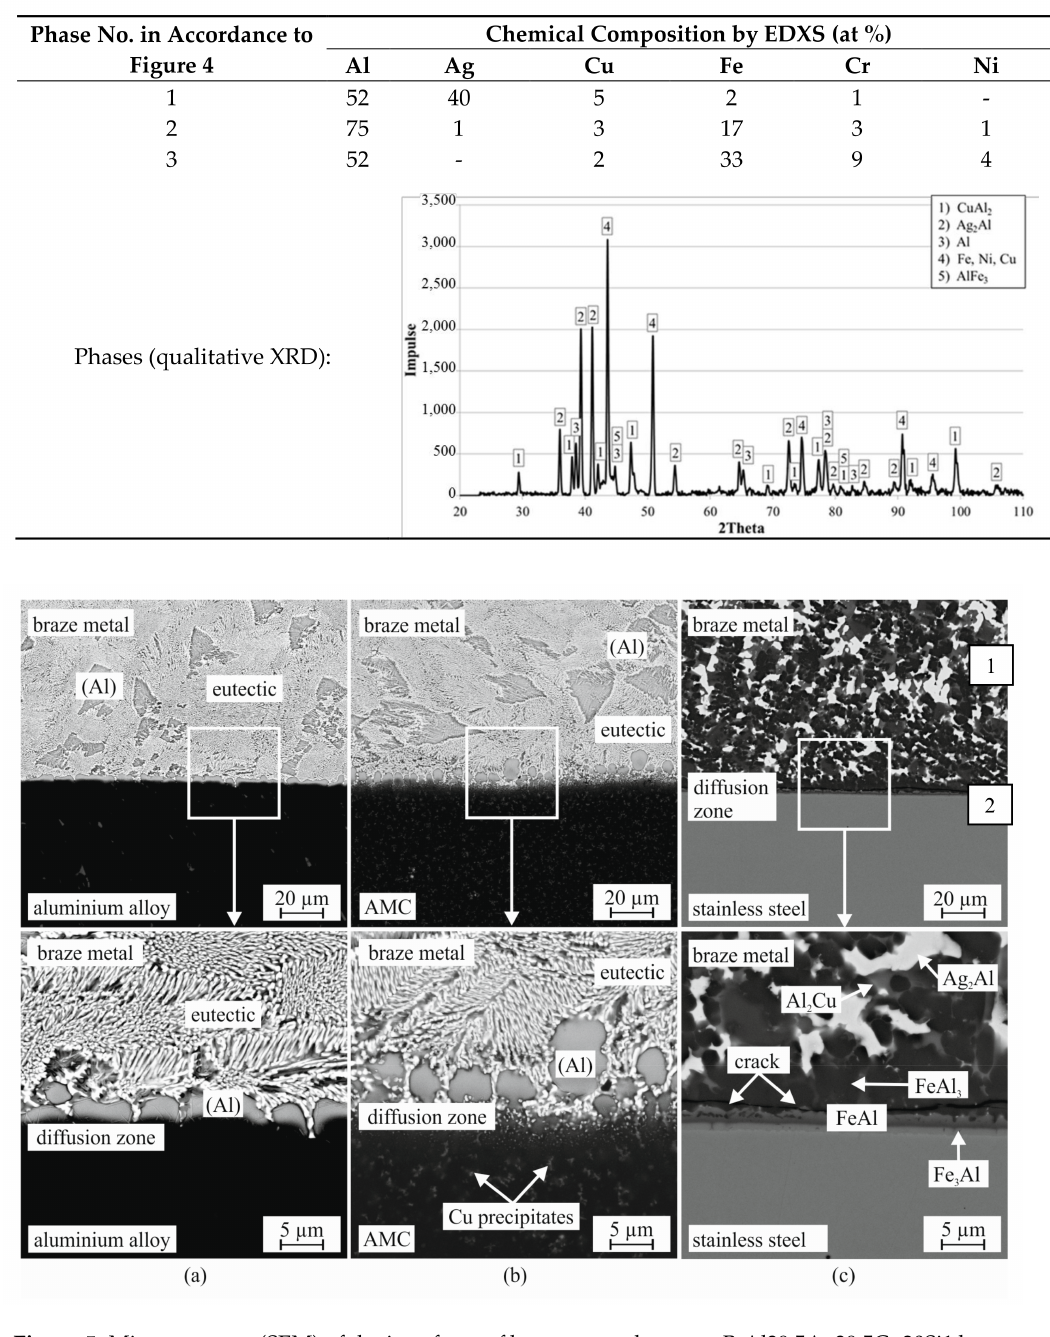
Figure 5. Microstructure (SEM) of the interfaces of braze seams between B-Al39.5Ag39.5Cu20Si1 braze filler and ( a ) aluminium EN AW-6082, ( b ) AMC EN AW-2017 + 10 vol % (SiC) P as well as ( c ) stainless steel AISI 304L